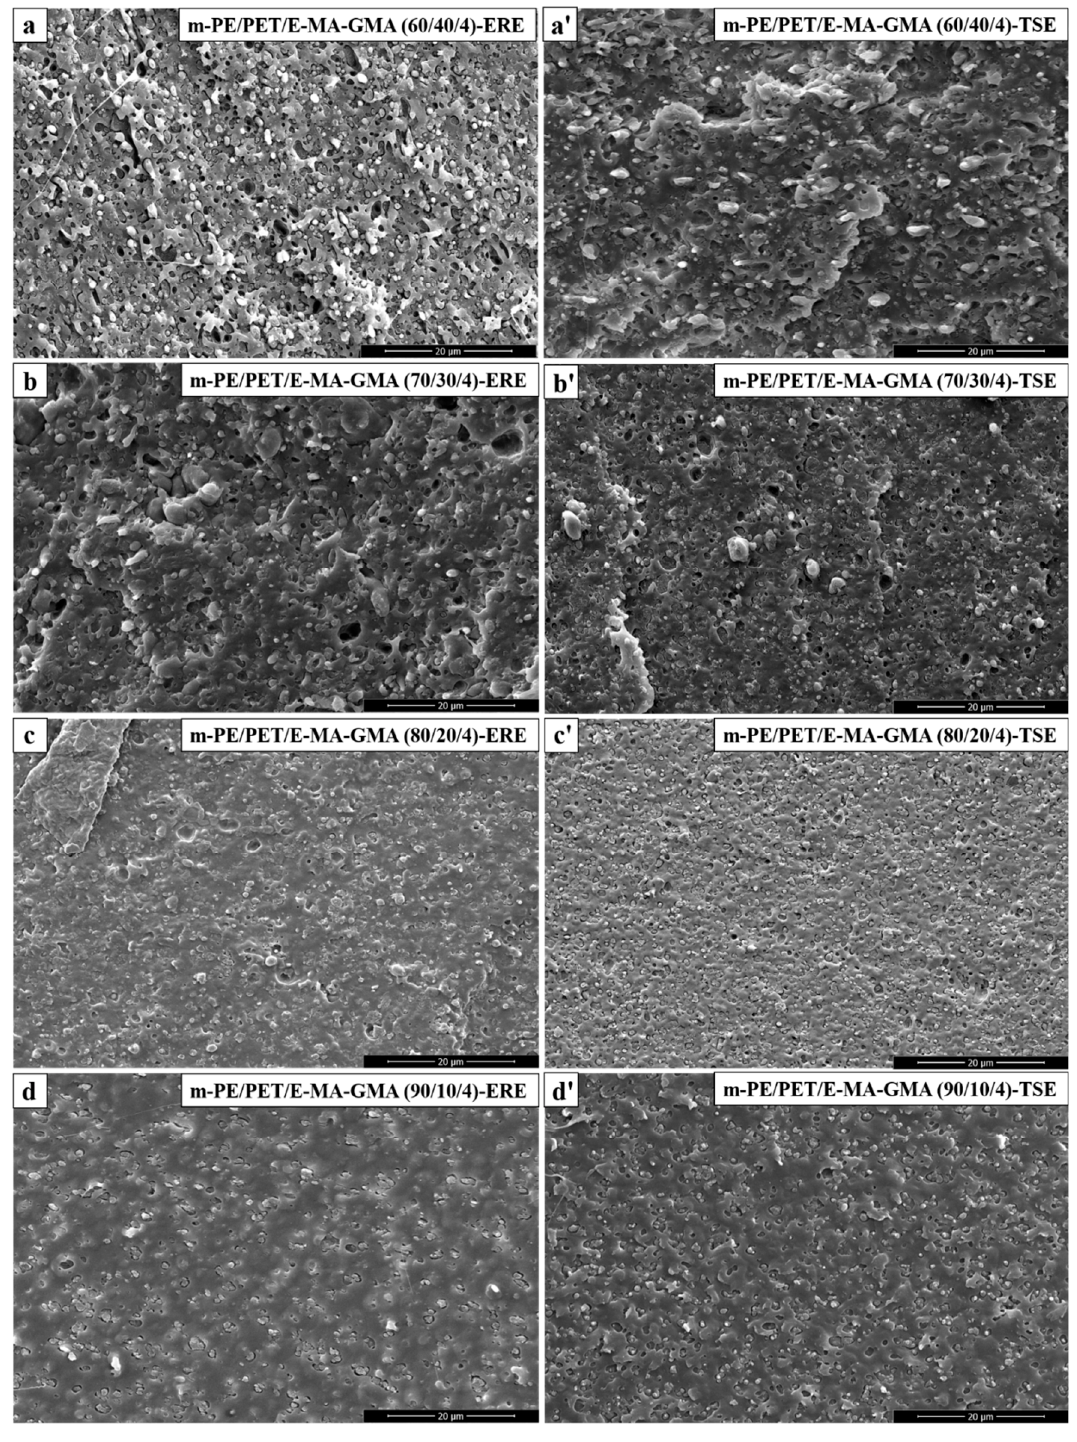
Figure 4. SEM micrographs of m-PE/PET/E-MA-GMA blends processed via ERE and TSE, respectively. ERE processed blends: ( a ) m-PE/PET/E-MA-GMA 60/40/4; ( b ) m-PE/PET/E-MA-GMA 70/30/4; ( c ) m-PE/PET/E-MA-GMA 80/20/4; ( d ) m-PE/PET/E-MA-GMA 90/10/4. TSE processed blends: ( a’ ) m-PE/PET/E-MA-GMA 60/40/4; ( b’ ) m-PE/PET/E-MA-GMA 70/30/4; ( c’ ) m-PE/PET/E-MA-GMA 80/20/4; ( d’ ) m-PE/PET/E-MA-GMA 90/10/4.